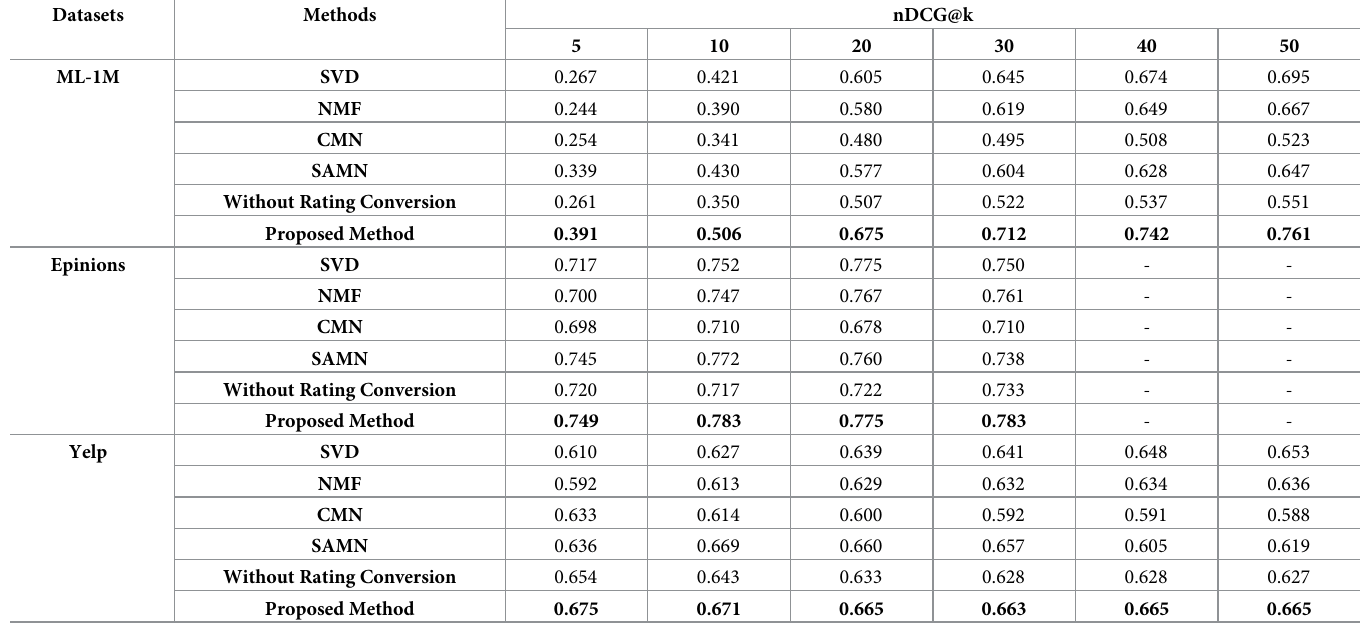
Table 5. Comparison of the experimental results on the ML-1M, Epinions, and Yelp datasets using nDCG.